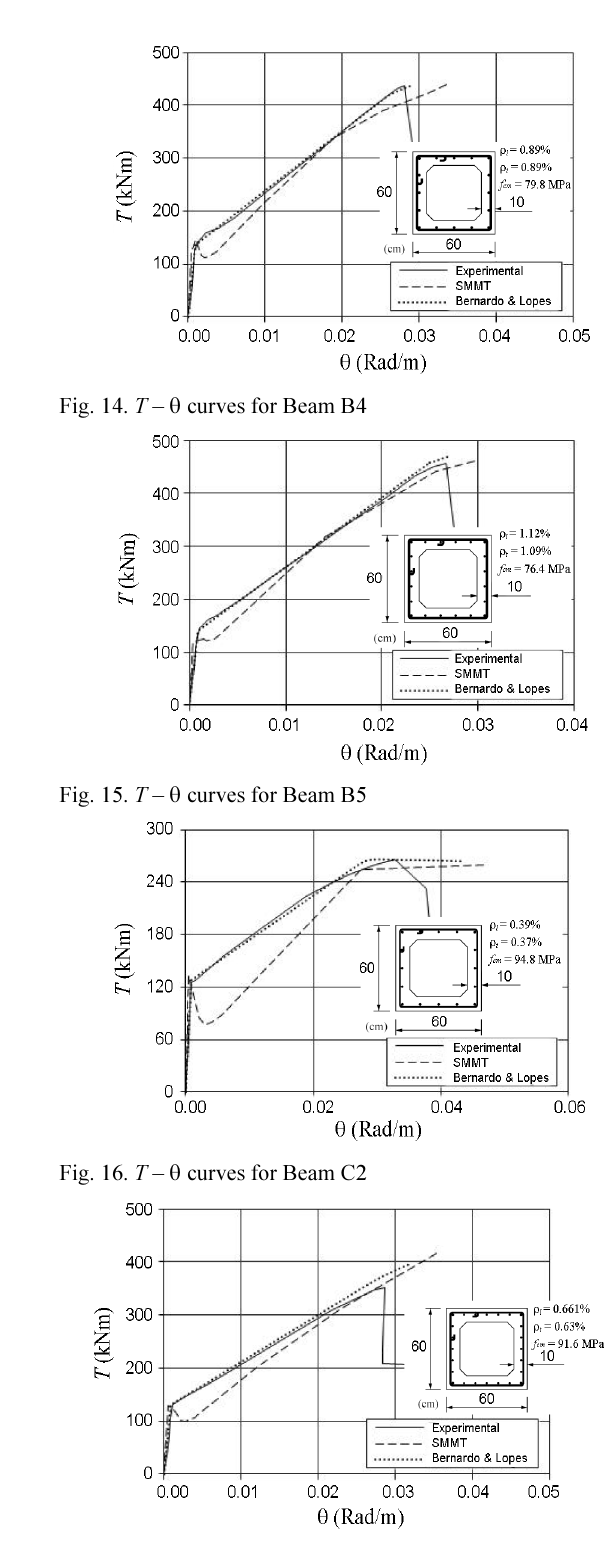
Fig. 17. T – θ curves for Beam